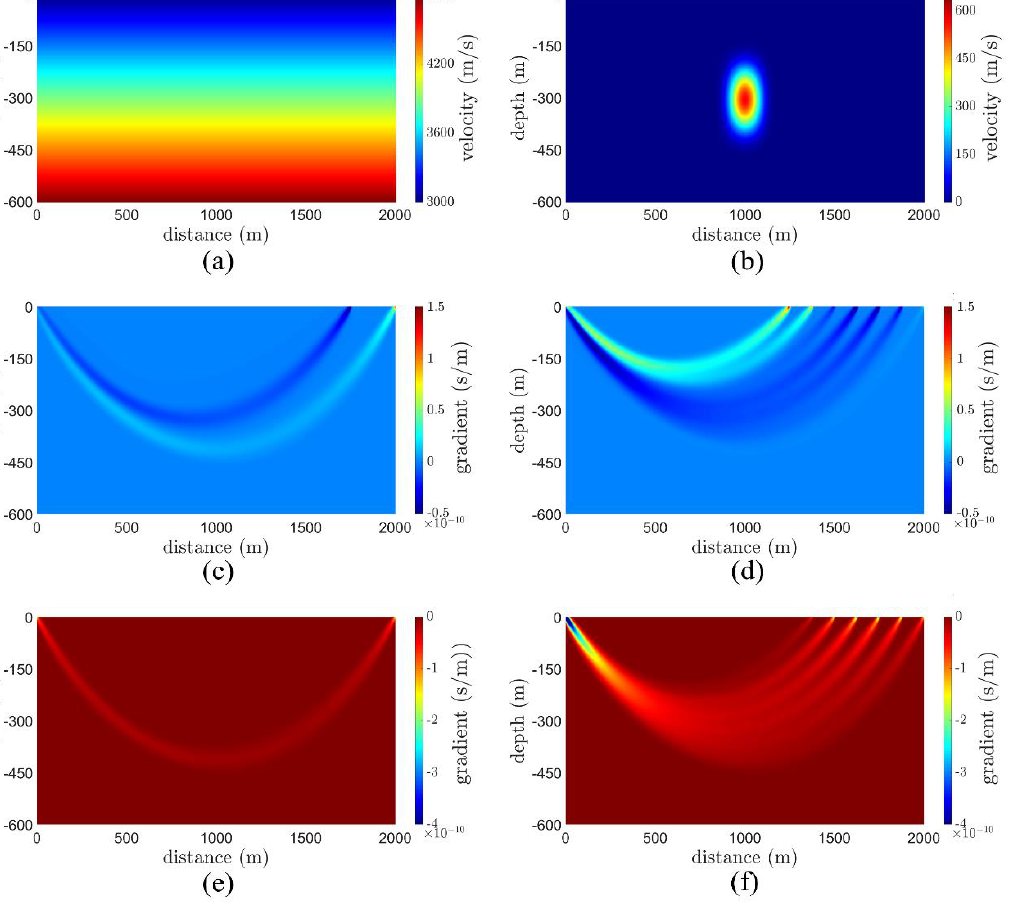
Figure 3. Two − dimensional numerical example for illustration of adjoint system. ( a ) Initial velocity model. ( b ) Velocity anomaly in numerical model. ( c ) Gradient of two source–receiver pairs obtained by TDAT. ( d ) Gradient of multiple source–receiver pairs obtained by TDAT. ( e ) Gradient of source– receiver pair obtained by FAAT. ( f ) Gradient of multiple source–receiver pairs obtained by